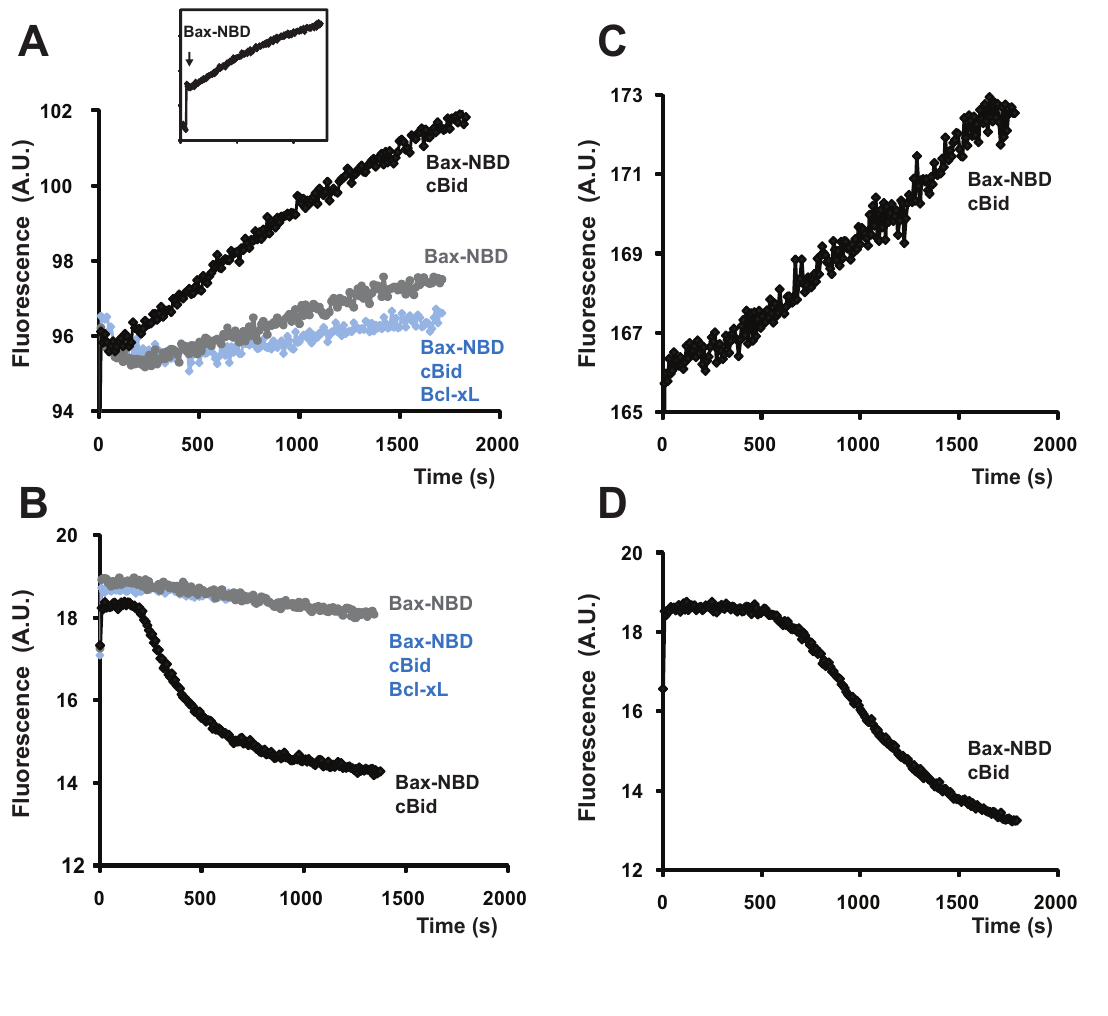
Figure 3. In OMVs, Bax membrane integration begins immediately upon addition of Bax, while dextran release displays a significant lag-phase. Bax membrane integration was measured by an increase in NBD-labeled Bax fluorescence. Kinetics of Bax insertion (A,C) and dextran-Cascade Blue release (B,D) were measured at two Bax-NBD concentrations: 100 nM (A,B) and 40 nM (C,D). Bax-NBD was added at time zero. When present, cBid (40 nM) and Bcl-xL (2 m M) were added 2–3 min prior to Bax-NBD. The insert shows an initial instantaneous increase in fluorescence upon Bax-NBD addition, followed by a gradual increase in the NBD signal. This time-dependent change in NBD fluorescence (reflecting membrane insertion) is shown on the graph (A). Bax membrane integration and dextran release both occur in a cBid-dependent, Bcl-xL-inhibitable manner but display different kinetics (see also Figure S3 showing measurements of Bax membrane binding by an independent method). Thus, Bax integration is rapid and cannot be the rate-limiting step occurring during the lag phase. See also Figure S2, showing that displacement reactions of Bcl-2-family proteins are also rapid and cannot explain the lag phase.